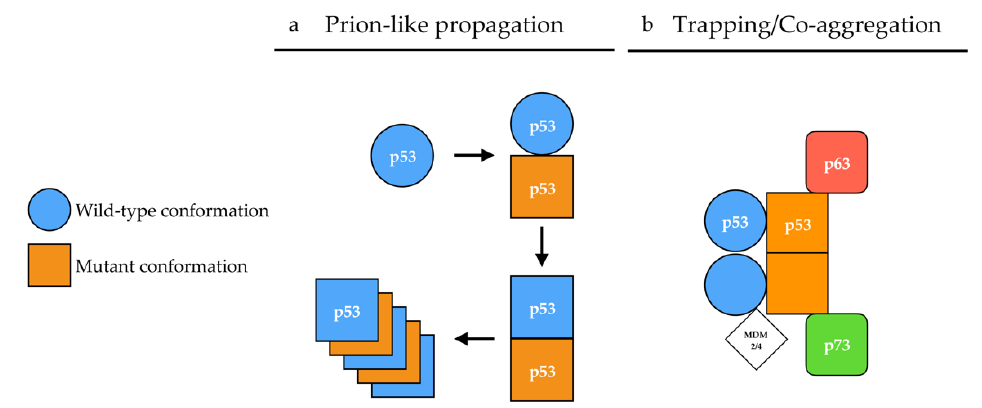
Figure 2. Proposed mechanisms of p53 aggregation. ( a ) According to the prion-like hypothesis, mutant p53 (orange) in a [p53 MUT ] conformation (square) induces a conformational shift of wild-type p53 (blue) from a [p53 WT ] (circle) conformation toward a [p53 MUT ] conformation in a prion-like manner. In a [p53 MUT ] conformation, wild-type and mutant p53 form amyloid fibers. ( b ) According to the co-aggregation/trapping hypothesis, mutant p53 hetero-tetramerizes with wild-type p53. The unfolded core of mutant p53 allows new interactions with p63/p73 isoforms and MDM2/4 in a trapping/co-aggregation mechanism.